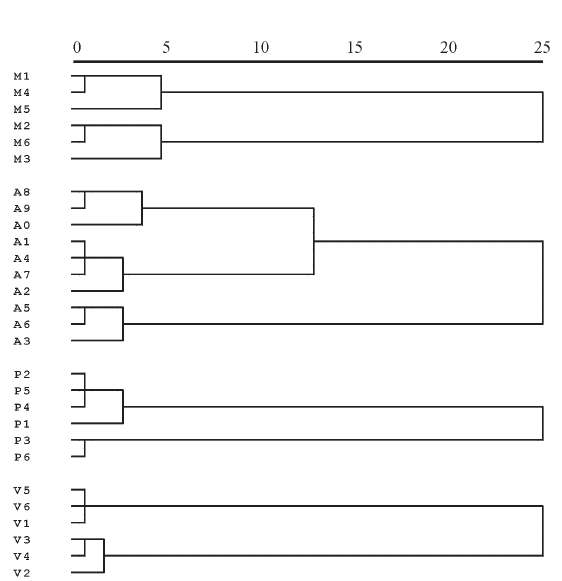
IG . 3. – Dendrogram of the ría by ría cluster analysis of the mean concentrations for each site, of nitrite, nitrate, ammonium and phos-